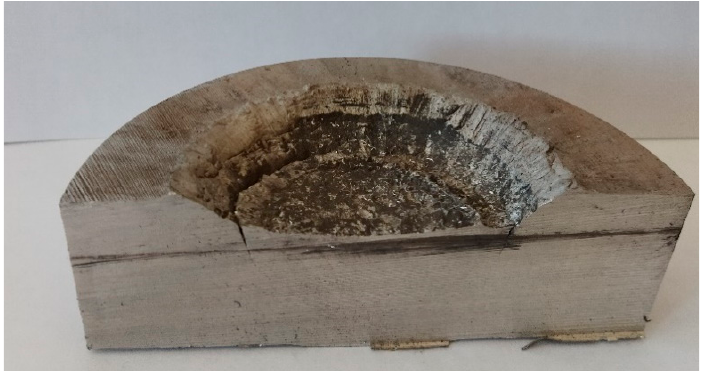
Figure 3. Aluminum plate cross-section after testing.